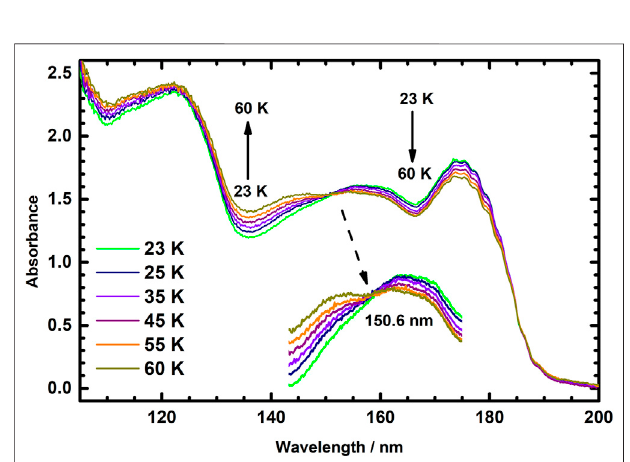
FIGURE 4 | Vacuum ultraviolet absorption spectra of icy C at temperatures 23, 25, 35, 45, 55, and 60 K in the wavelength range 105 – 200